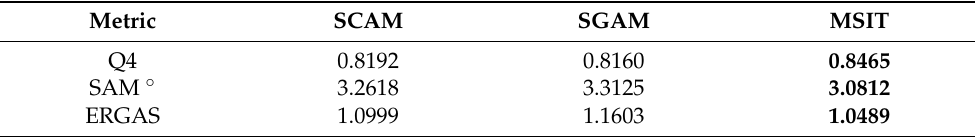
Table 7. Numerical evaluations of the fused images in Figure 11 (GeoEye-1 dataset). Metric SCAM